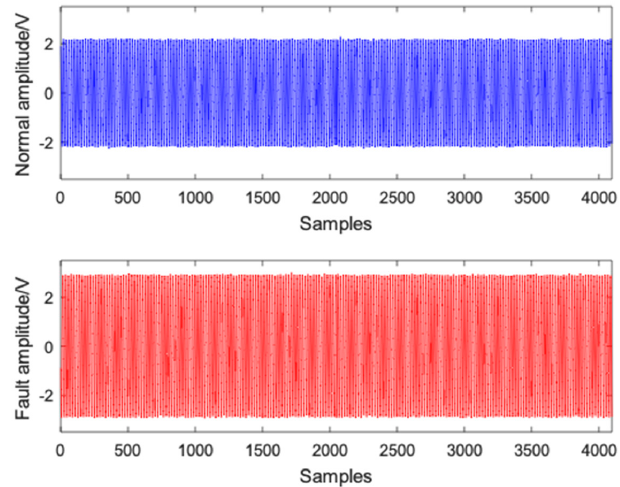
Figure 2. Two of the collected current signals.